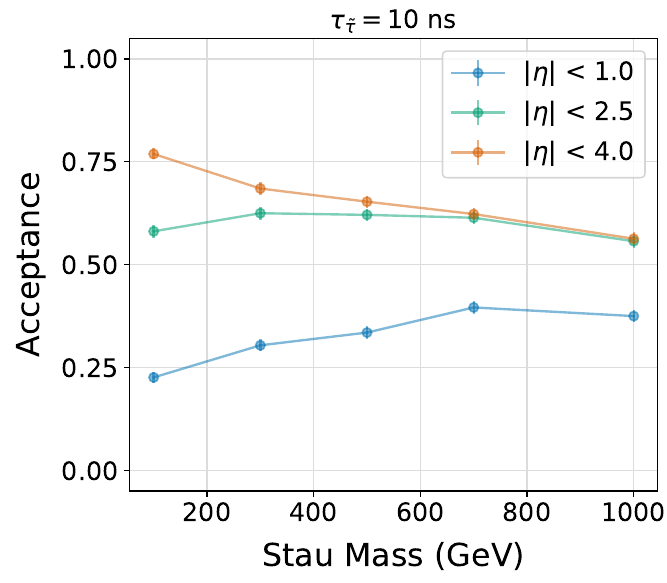
Figure 16. Stau model event-level acceptance for a variety of minimum tracker | η | values. Accep- tance is shown as a function of stau mass for proper lifetime τ = 10 ns. The stau is required decay beyond L = 1200 xy